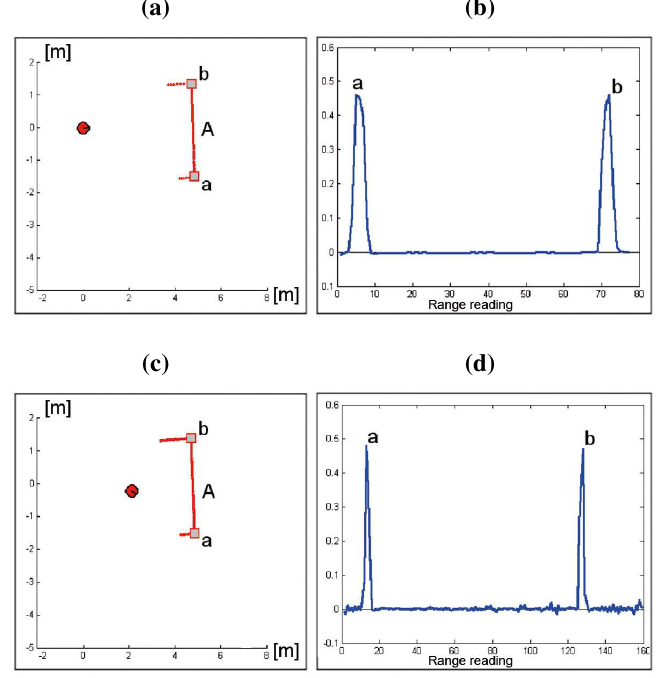
Figure 9. (a) Laser scan #1. (b) Adaptive TAR associated to scan segment A in (a). (c) Laser scan #2. (d) Adaptive TAR associated to scan segment A in